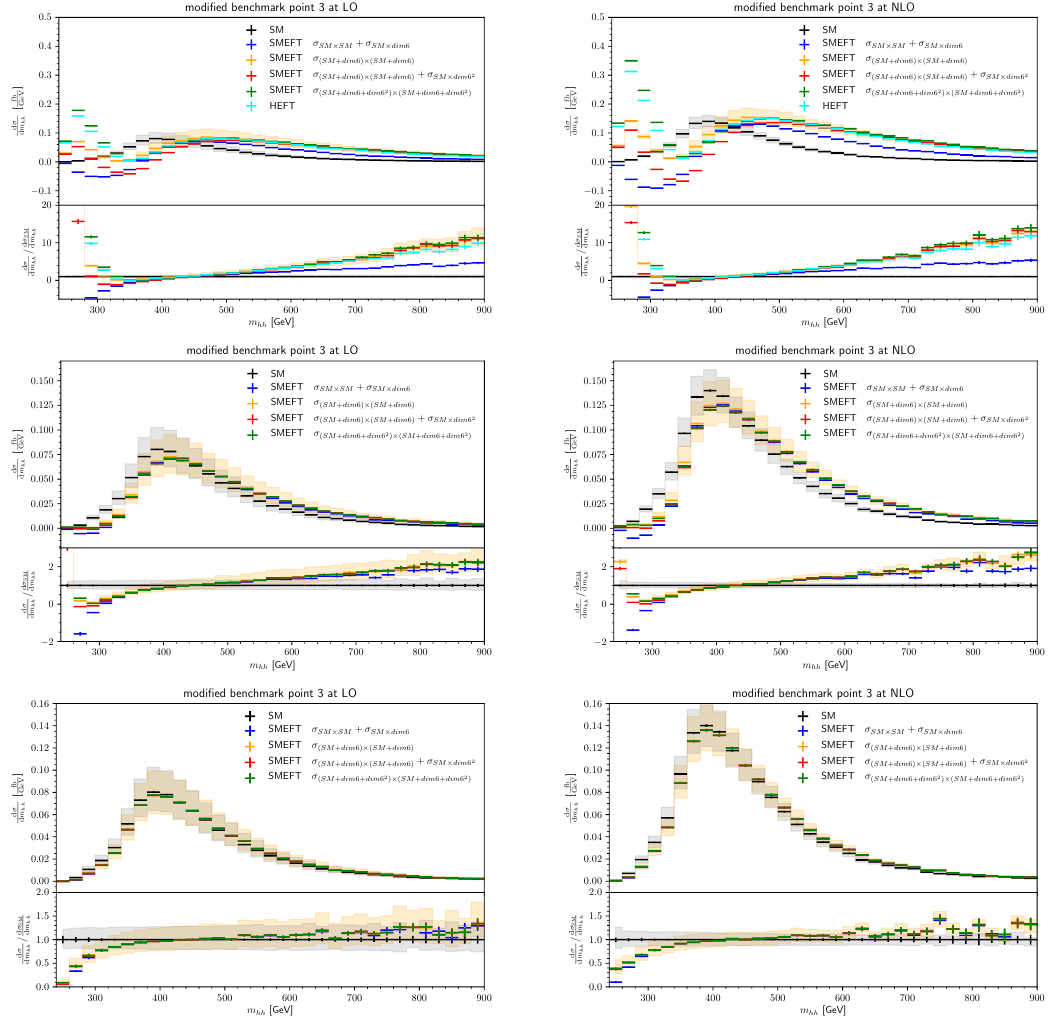
Figure 3 . Differential cross sections for the invariant mass m hh of the Higgs-boson pair for benchmark point 3 of table 2. Top row: Λ = 1 TeV, middle row: Λ = 2 TeV, bottom row: Λ = 4 TeV. Left: LO, right: